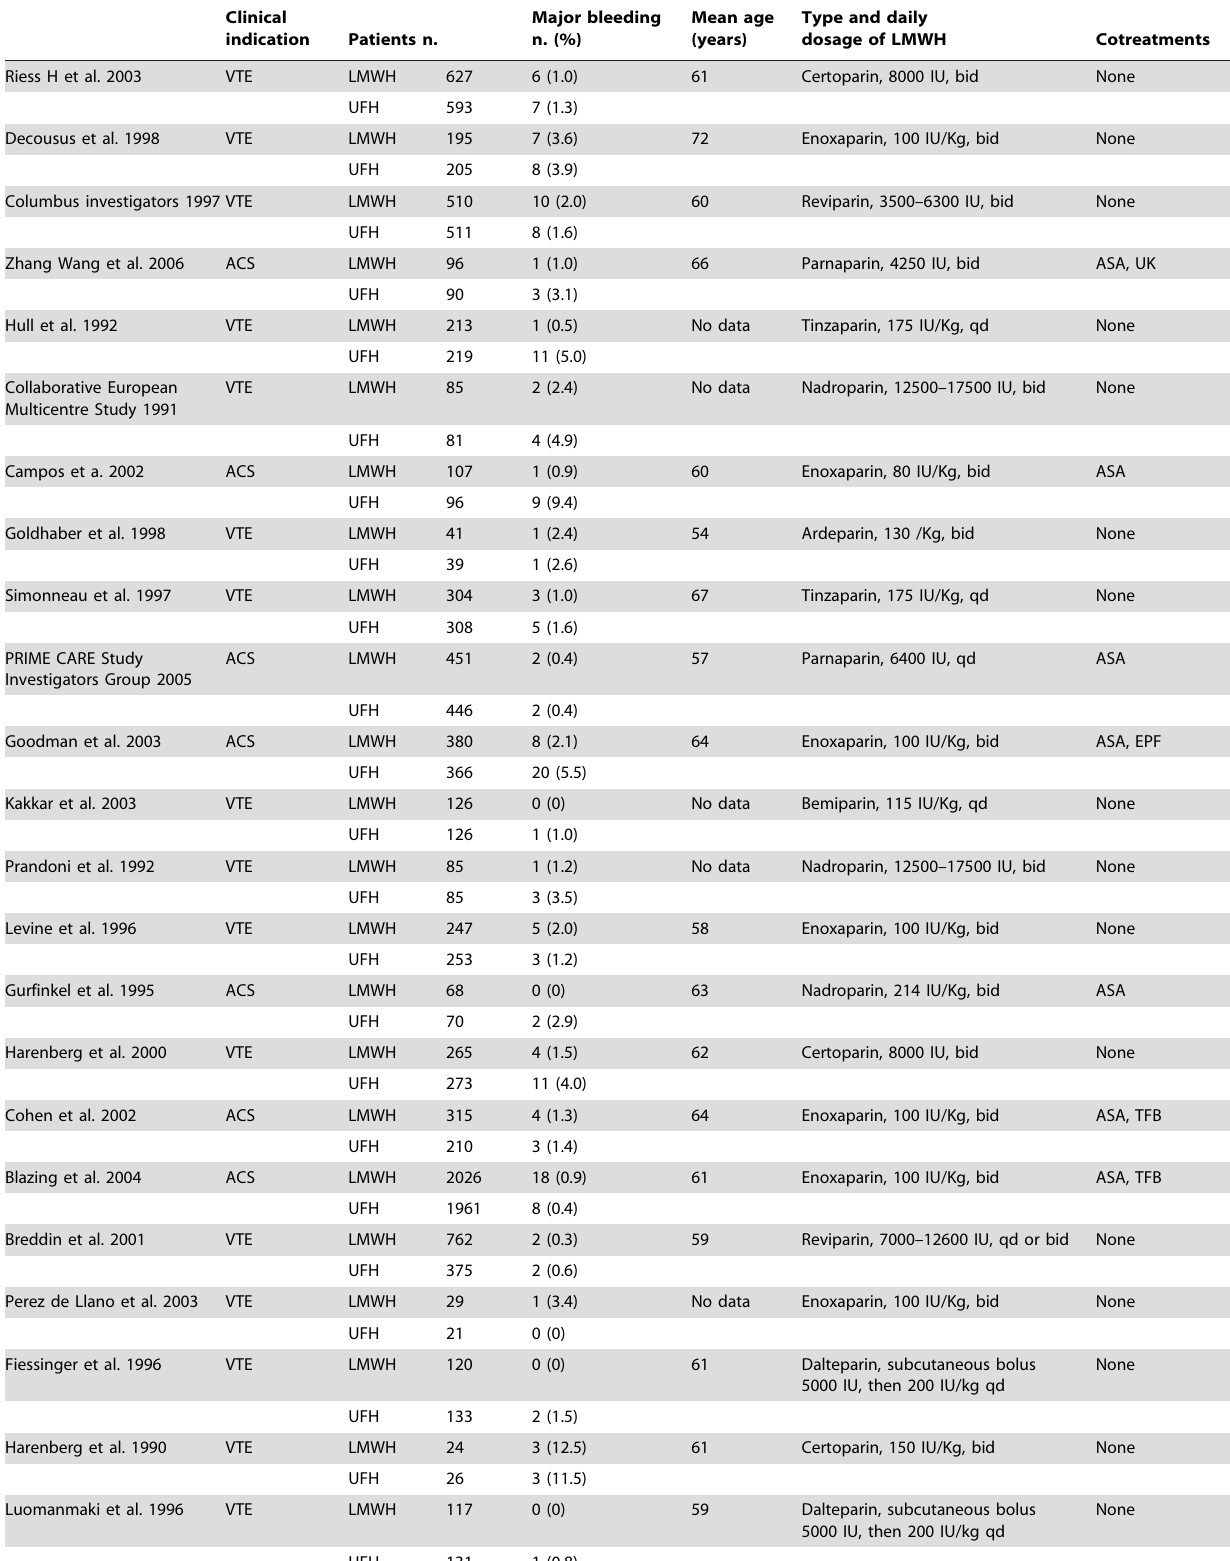
Table 1. Characteristics of included studies.